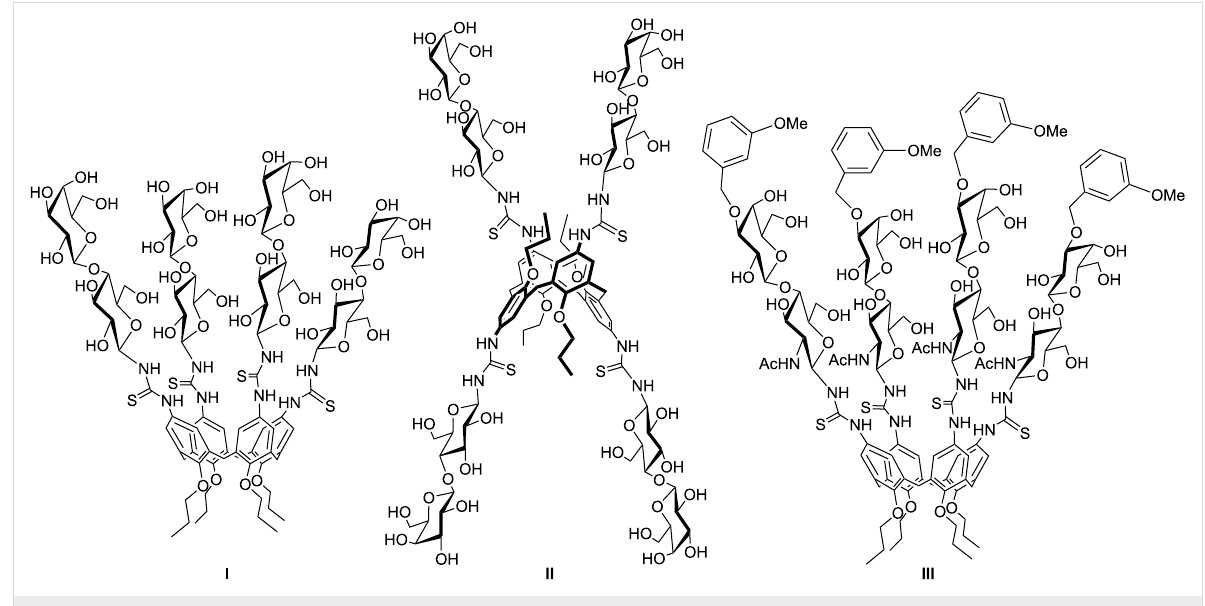
Figure 1: Lactosylthioureidocalix[4]arenes I–III used to inhibit Gal-3